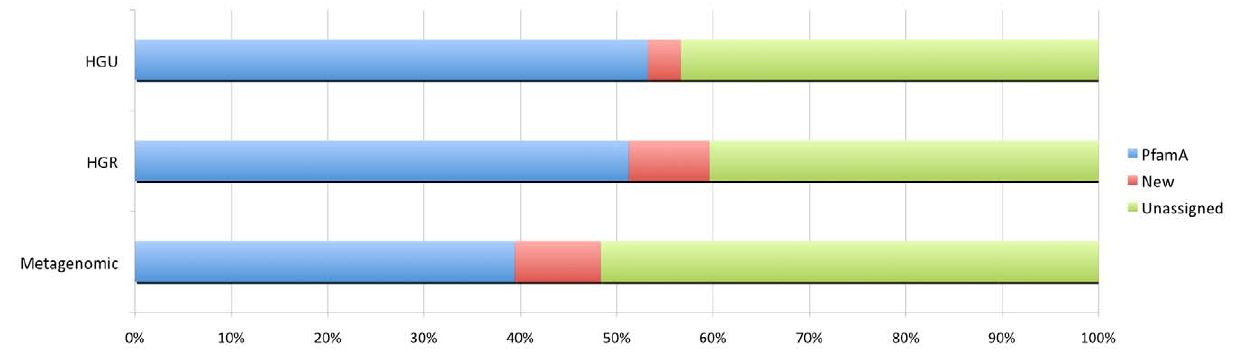
Figure 1. Coverage of genomic and metagenomic datasets with protein families. Sequence sets include Human Gut Related(A), Human Gut Unrelated(B) and Metagenomic sequences(C). The unassigned proteins (green) consist of singletons and small sequence clusters (see text for details).